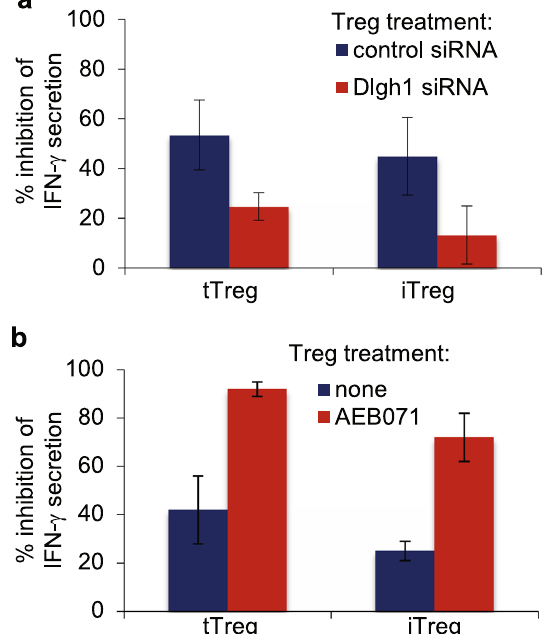
Figure 4. The suppressive function of both tTregs and iTregs is concurrently regulated via Dlgh1/PKC- θ signaling pathways. Treg subsets, tTregs and iTregs were transfected with small interfering RNA (siRNA) targeting Dlgh1 or with control siRNA by AMAXA and plated in presence of IL-2 (300 IU/ml) ( a ) or pre- treated with PKC- θ inhibitor (AEB071) at 10 μ M for 30 min and washed three times ( b ). SiRNA-transfected ( a ) or AEB071-treated ( b ) Tregs were mixed with CD4 + CD25 − T cells at 1:3 ratio and plated on immobilized anti-CD3 antibodies (5 μ g/ml). The supernatants were analyzed for IFN- γ secretion after 48 hours by ELISA. Data are representative of two different